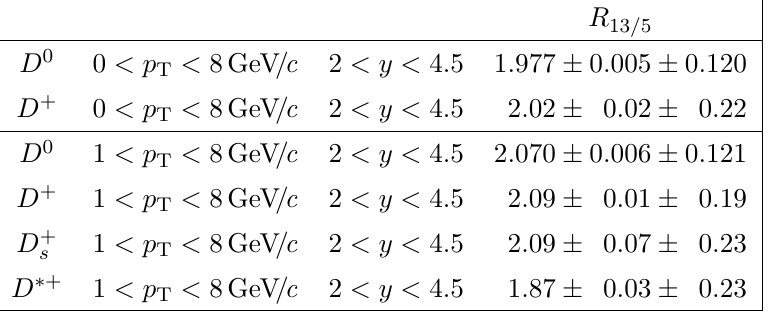
Table 4. Ratios of integrated prompt D -meson production cross-sections between measurements at p s = 13 TeV and p s = 5 TeV. The (cid:12)rst uncertainty on the ratio is statistical, and the second is systematic.